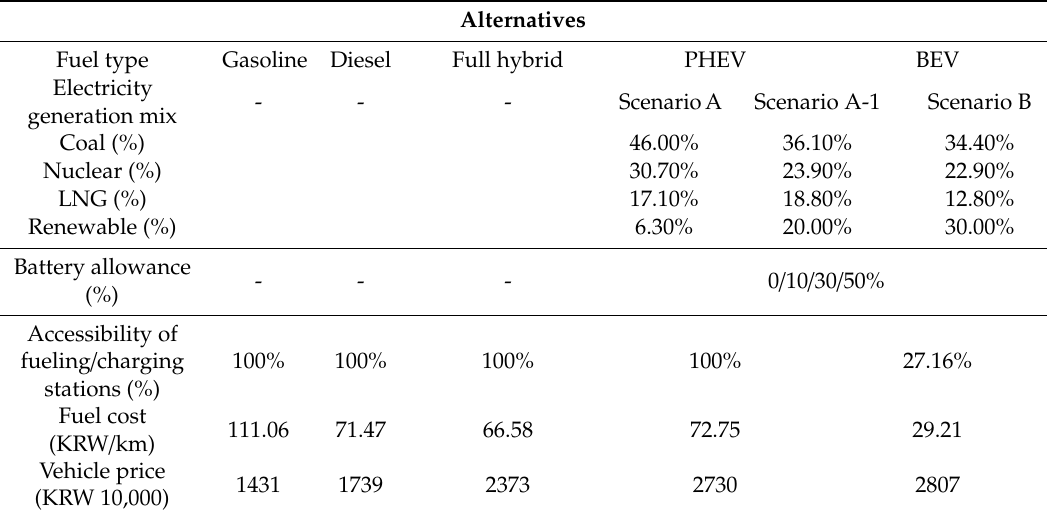
Table 5. Attribute levels used in the market